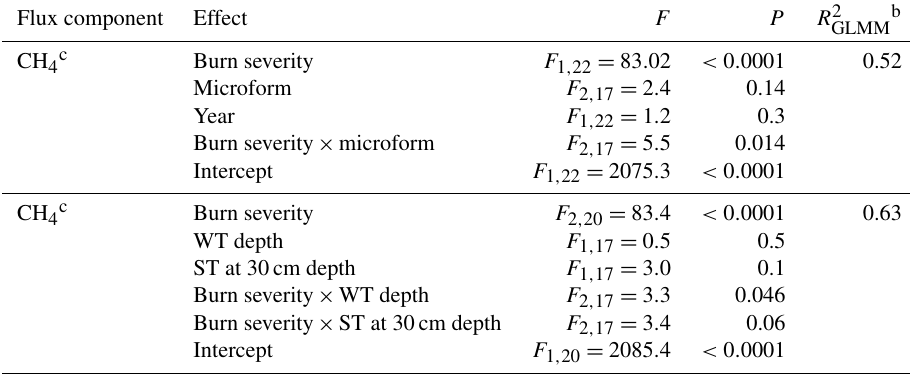
Figure 3. Seasonal mean methane (CH 4 ) flux at each collar across the peat burn severity gradient plotted against seasonal mean water table (WT) depth. UB is unburned, MB is moderately burned and SB is severely burned. Note that CH 4 values were log transformed + 10; therefore, a value of 1 represents the measured value zero. Table 2. Statistical results of the linear mixed effects model a